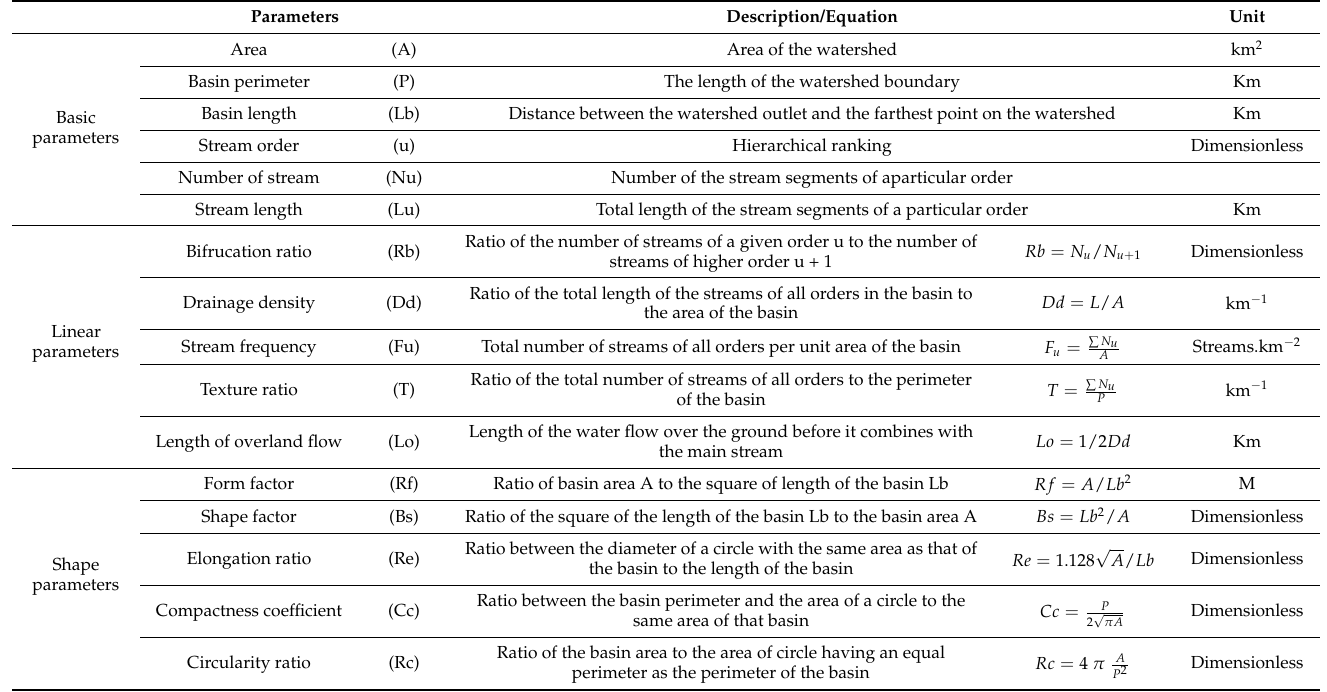
Table 7. Morphometric